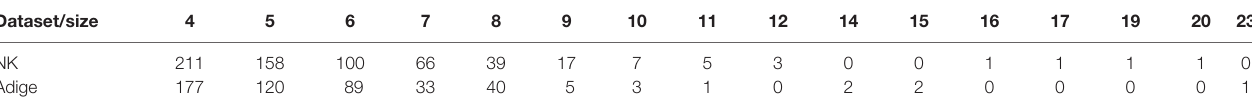
TaBle 3 | Number of cliques grouped by size.